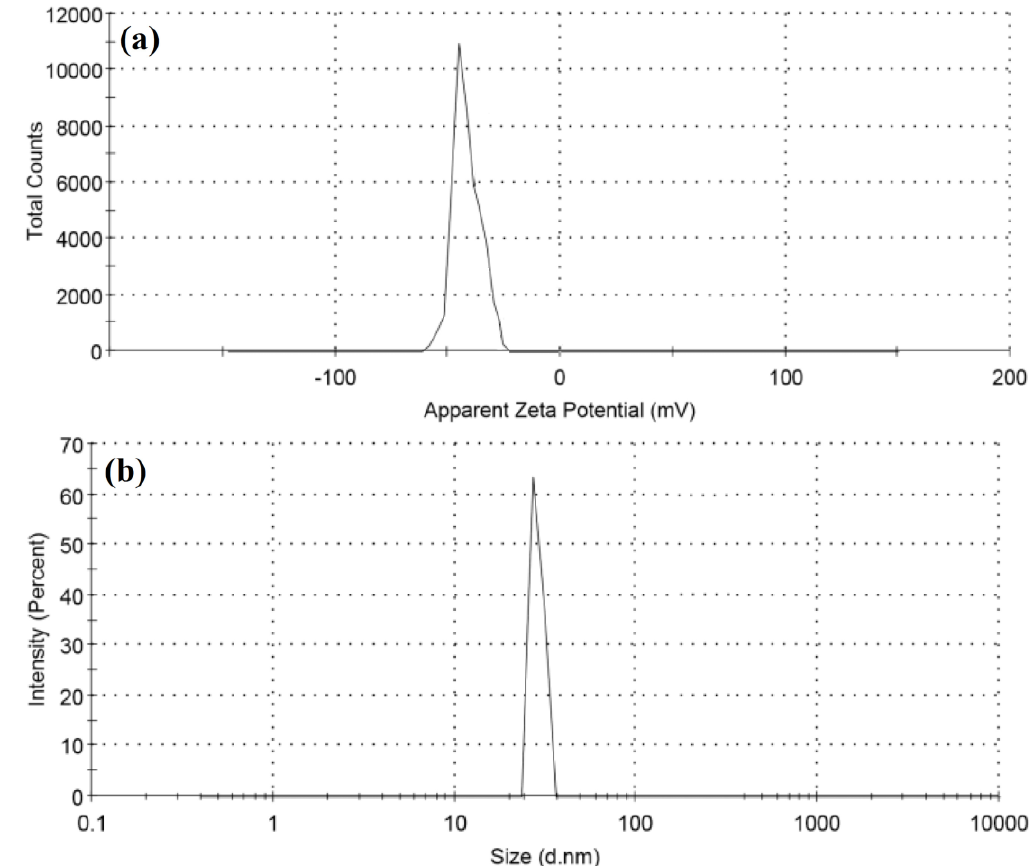
Figure 4. ( a ) Zeta potential and ( b ) particle size distribution of ZnO NPs.